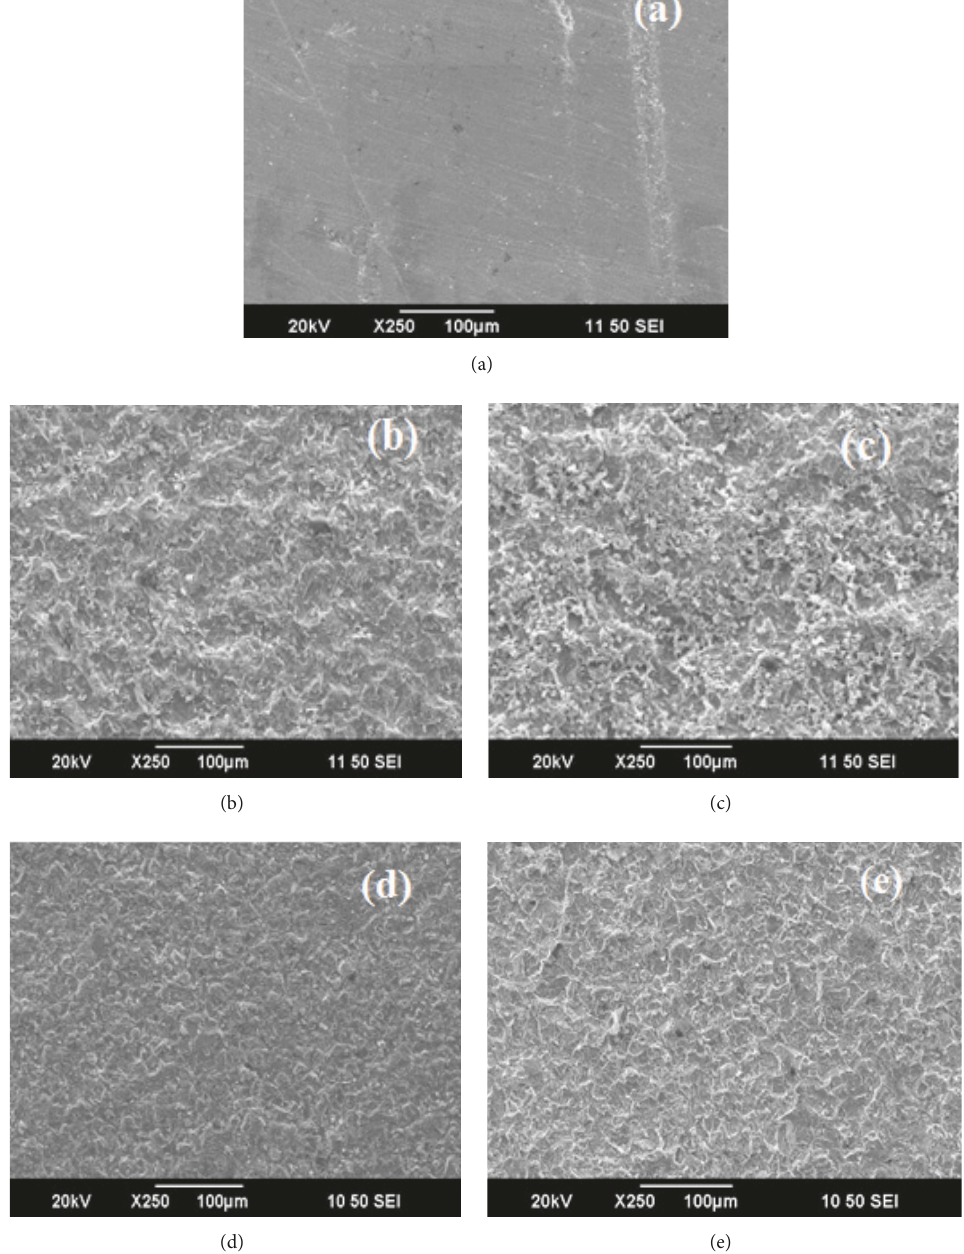
Figure 12: SEM analysis of MS coupons before and after 24 h immersion: (a) bare, (b) blank (HCl), (c) blank (H 2 SO 4 ), (d) treated with DmChDp (1mM) in 1M HCl, (e) treated with DmChDp (1mM) in 0.5M H 2 SO 4